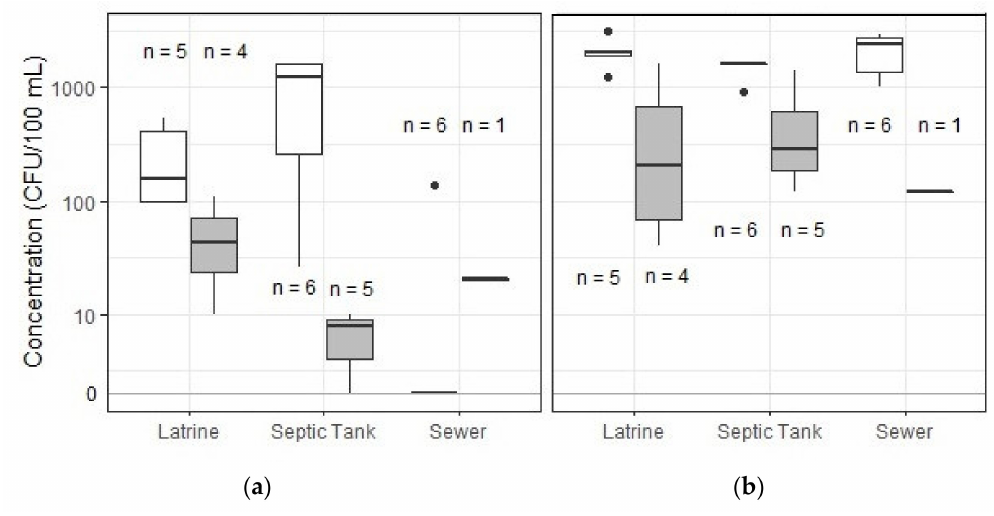
Figure 12. ( a ) E. coli and ( b ) TC concentration in water samples from households with a latrine/septic tank/small-scale sewer and a dug well/shallow well.